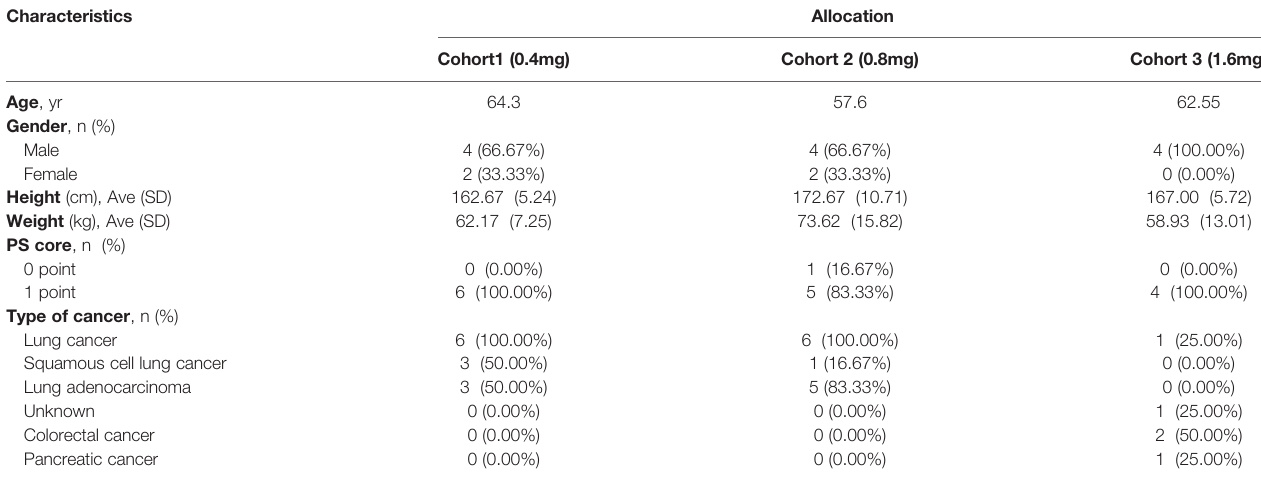
TABLE 1 | Baseline